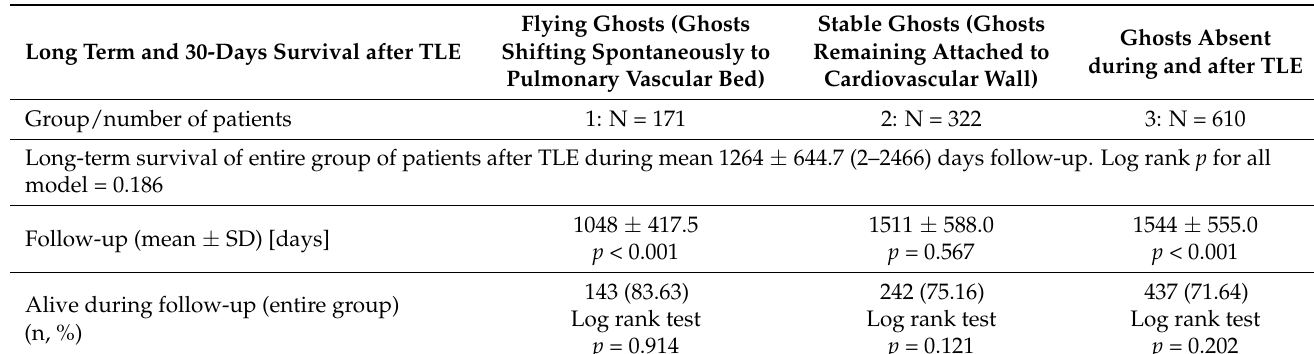
Table 3. Long term and 30-d survival after